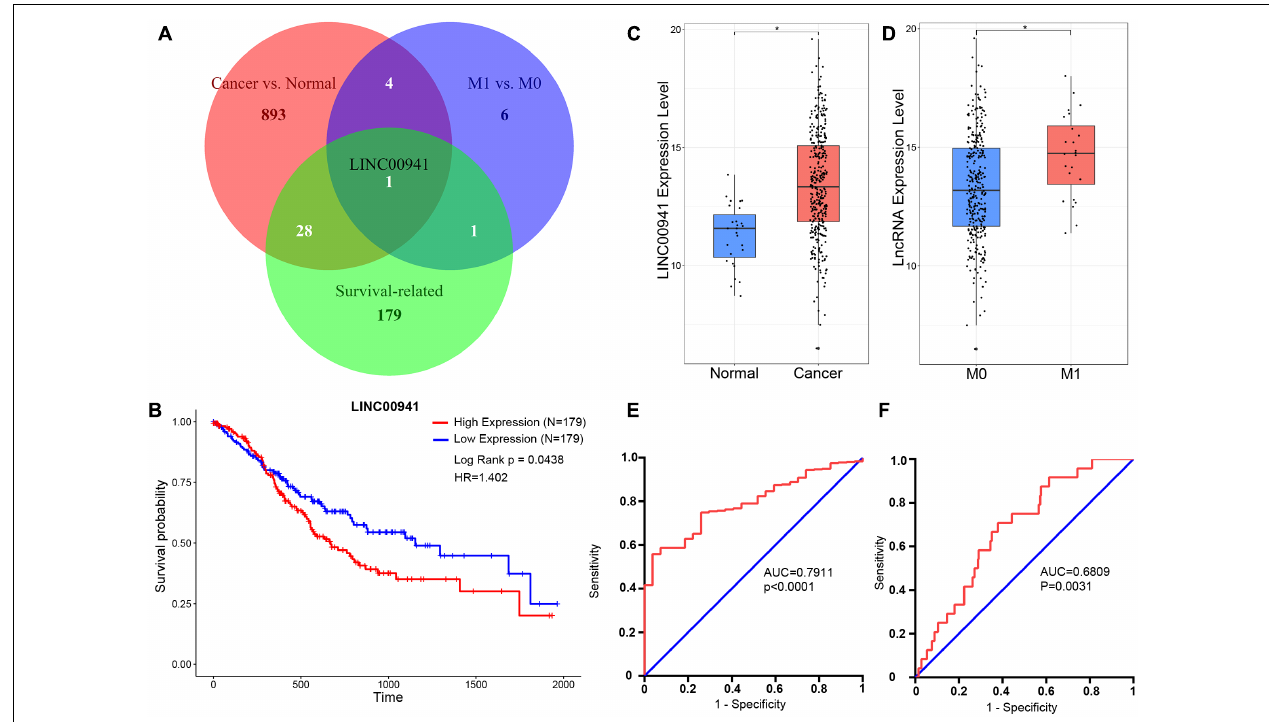
FIGURE 1 | LINC00941 is potential diagnosis and prognosis biomarker for GC. (A) Venn diagram showed that only LINC00941 presented in the overlap of three data sets. (B) High expression of LINC00941 was associated with poor prognosis in GC. (C) LINC00941 were up-regulated in cancer samples, ∗ p < 0.05. (D) LINC00941 was significantly up-regulated in M1 samples, ∗ p < 0.05. (E) The ROC curve analysis for discriminative ability between cancer samples and normal samples. (F) The ROC curve analysis for discriminative ability between M1 samples and M0